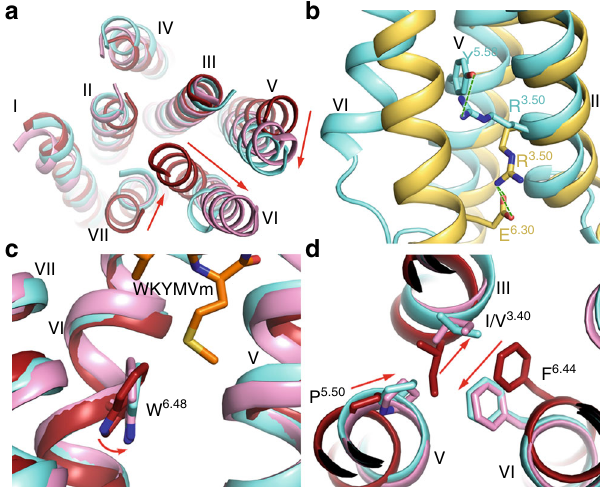
Fig. 2 Active conformation of the FPR2-WKYMVm complex. a The movement of helix VI. The transmembrane helical bundles in the structures of FPR2-WKYMVm (cyan), μ OR-BU72 (pink, PDB code: 5C1M) and μ OR- naloxone (dark red, PDB code: 4DKL) are shown in cartoon representation at an intracellular view. The red arrows indicate the movements of helices V, VI, and VII in the FPR2-WKYMVm and μ OR-BU72 (active) structures relative to the μ OR-naloxone (inactive) structure. b The hydrogen bond interaction between R 3.50 and Y 5.58 in FPR2. The FPR2 residues R 3.50 and Y 5.58 are shown as cyan sticks. The inactive A 1 AR-DU172 structure (PDB code: 5UEN) is shown in yellow cartoon representation. The A 1 AR residues R 3.50 and E 6.30 that form a salt bridge are shown as yellow sticks. The polar interactions are shown as green dashed lines. c The conformational change of W 6.48 . The structures of FPR2-WKYMVm (cyan), μ OR-BU72 (pink), and μ OR-naloxone (dark red) are shown as cartoons. The residue W 6.48 in the three structures is shown as sticks. The red arrow indicates the movement of W 6.48 side chain in the FPR2-WKYMVm and μ OR-BU72 (active) structures relative to the μ OR-naloxone (inactive) structure. d The conformational change of the P 5.50 I/V 3.40 F 6.44 motif. The residues at positions 3.40, 5.50, and 6.44 in the structures of FPR2-WKYMVm (cyan), μ OR-BU72 (pink), and μ OR-naloxone (dark red) are shown as sticks. The red arrows indicate the relocations of these residues in the FPR2- WKYMVm and μ OR-BU72 (active) structures relative to the μ OR-naloxone (inactive)